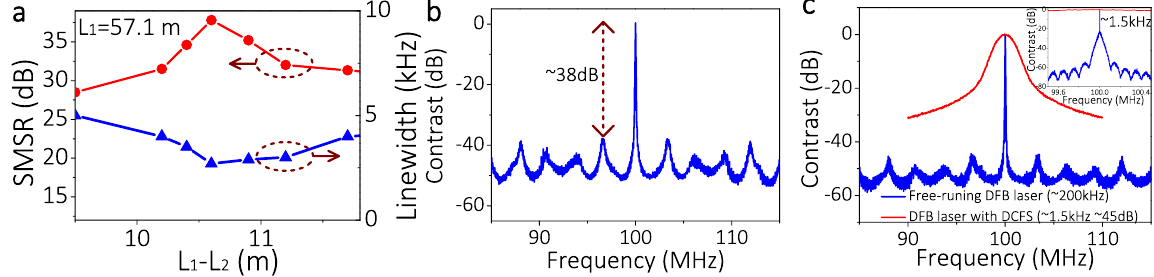
Figure 7. ( a ) SMSRs and linewidths with finely tuned feedback length. ( b ) Output power spectrum when results demonstrated that laser linewidthes of ~1 MHz and ~200 kHz were successfully compressed to ~2.7 and ~1.5 kHz with a side mode suppression ratio of 38 and 45 dB, respectively, by using DCFS. The proposed DCFS can also be applied in distributed Bragg reflector fiber laser, Fabry-Pérot laser diode (FP-LD) or other high finesse optical feedback systems to further compress laser linewidth. Methods Linewidth measurement method.